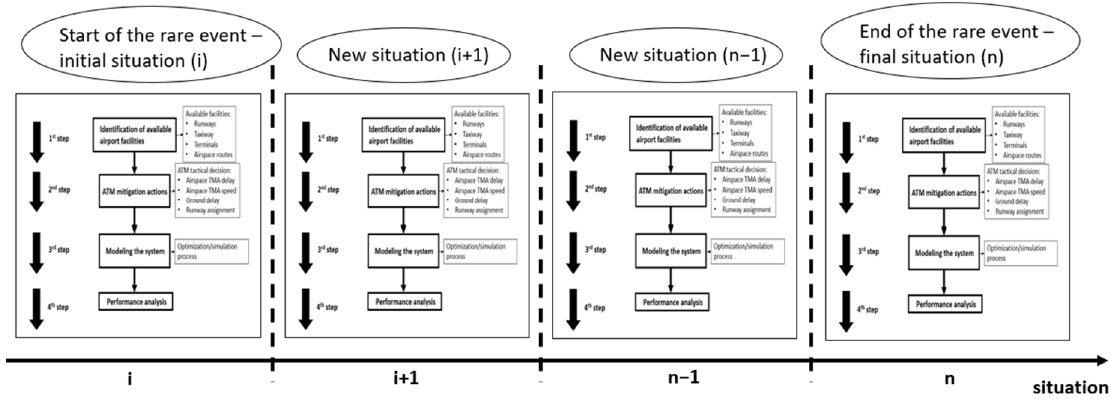
Figure 2. Methodology applied to the evolution of the rare event.